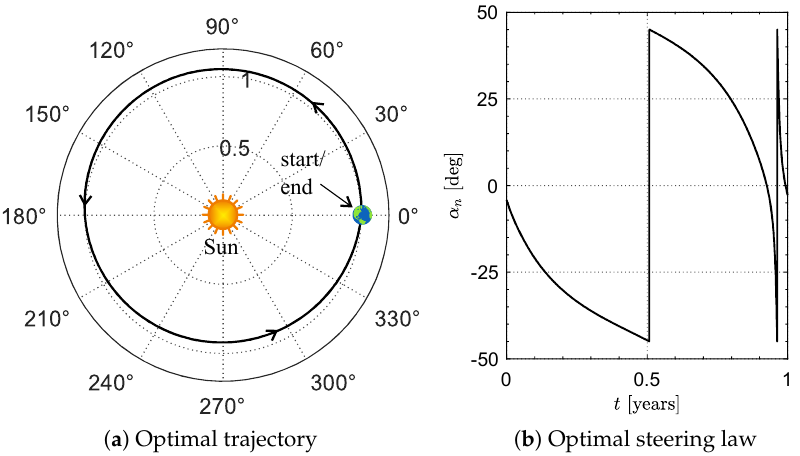
Figure 4. ∆ V -EGA maneuver trajectory and corresponding optimal steering law α n = α (cid:63) n ( t ) for = 1km/s, and t = 1year. a c = 0.2mm/s 2 , V ∞ f 0